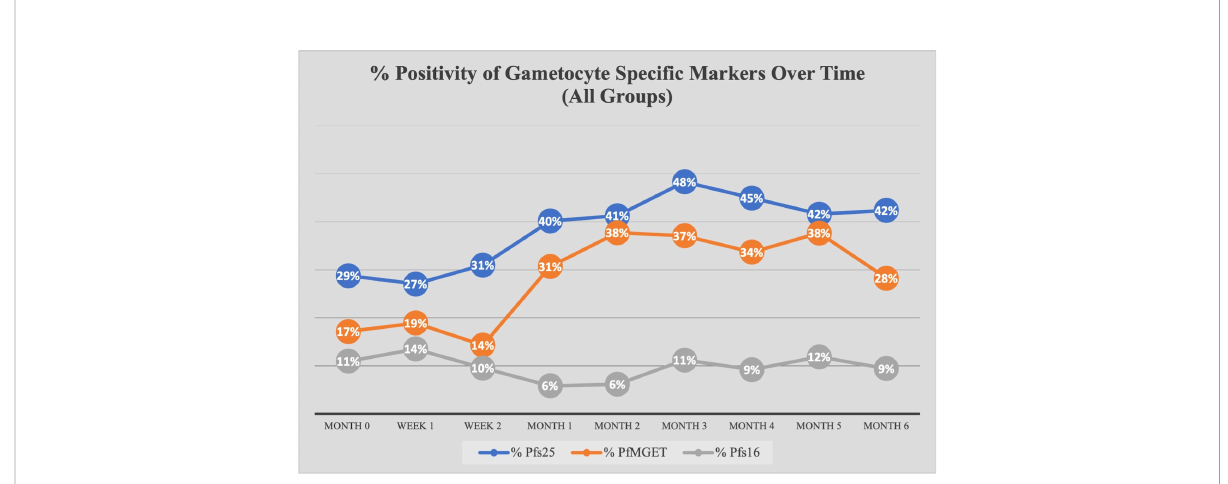
FIGURE 3 Percent Positivity of Each Gametocyte-Speci fi c Marker Over Time for All Study Groups. The prevalence of each gametocyte-speci fi c transcript biomarker (as a percentage of total analyzed) at each time